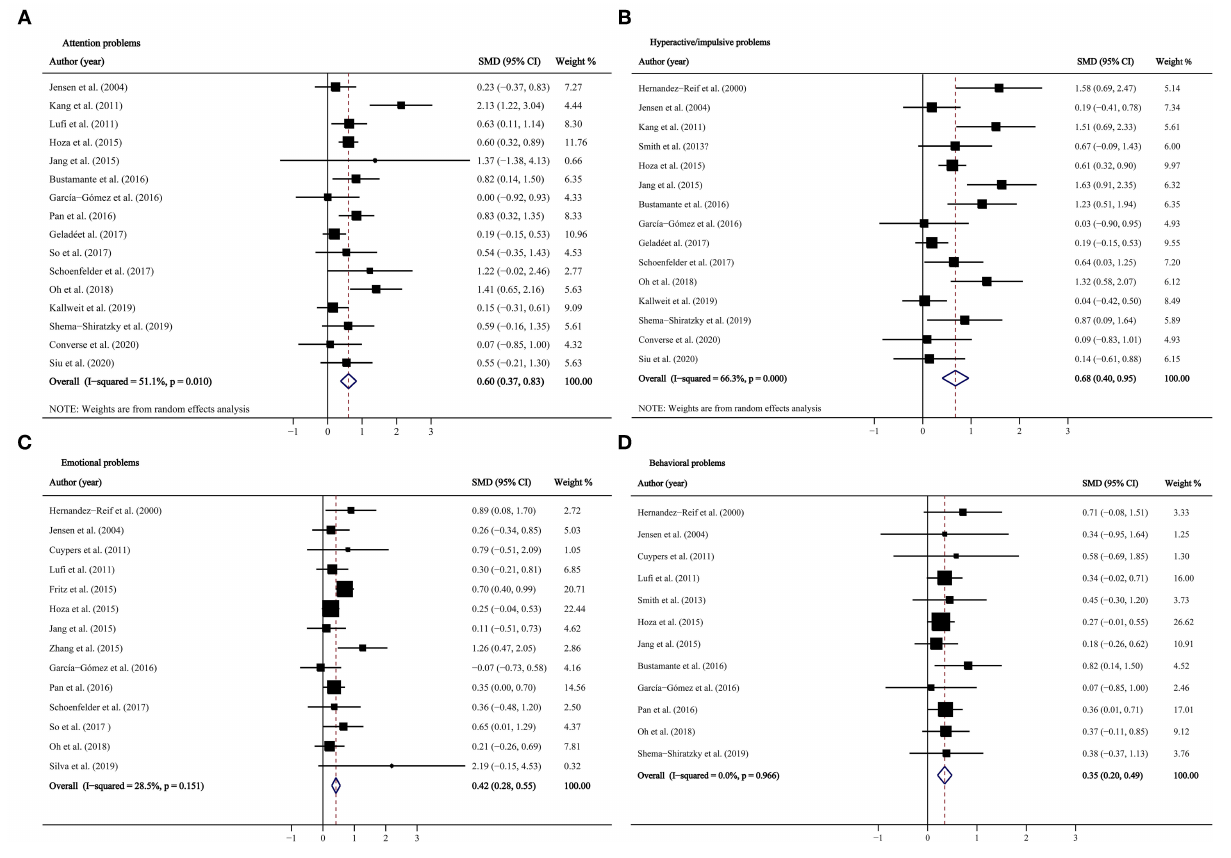
hyperactivity/impulsivity: SMD